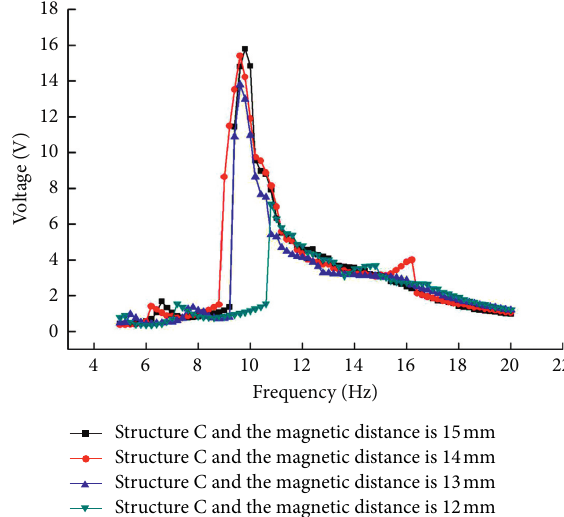
Structure C and the magnetic distance is 15mm Structure C and the magnetic distance is 14mm Structure C and the magnetic distance is 13mm Structure C and the magnetic distance is 12mm Figure 12: Relation of the voltage-frequency of different magnetic distances. Table 2: Comparison of the power generation efficiency of the structure A, the structure B, and the structure C is given when the external excitation amplitude is studied.